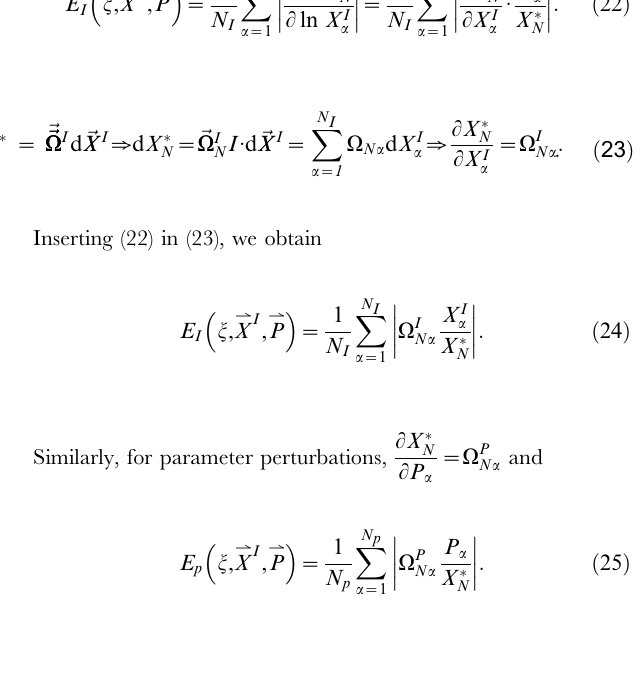
G I j ð Þð Þ and 10